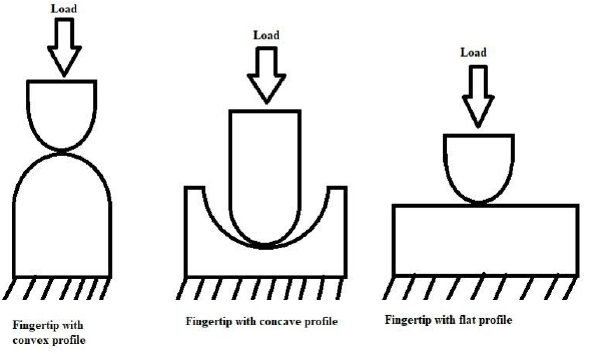
Figure 3: Fingertip pressed against various